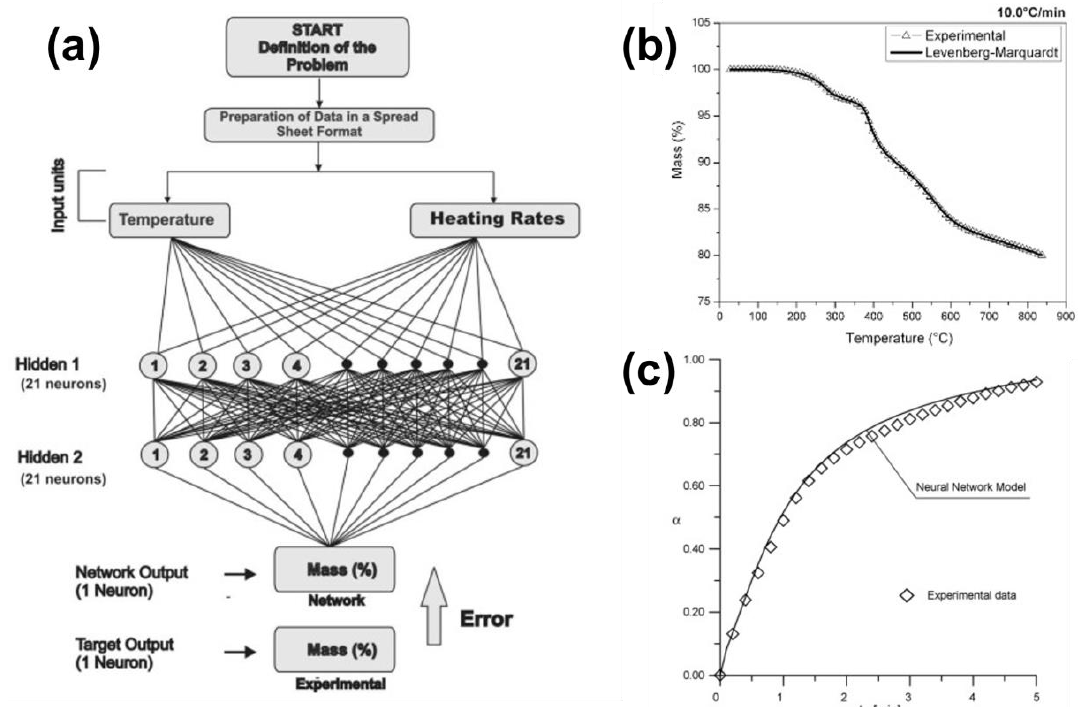
Figure 5. Typical approach to thermal signal fit with ANN model: ( a ) the workflow [20], and examples of use ( b , c ). Nonisothermal data ( b ) corresponds to the pyrolysis of carbon reinforced carbon composite (heating rate of 10 K min − 1 ) [20]. Isothermal data ( c ) represents the iron oxide reduction ( T = 880 °C, environmental gas 90% N 2 + 10% CO) [19]. Reprinted with permission from Elsevier.